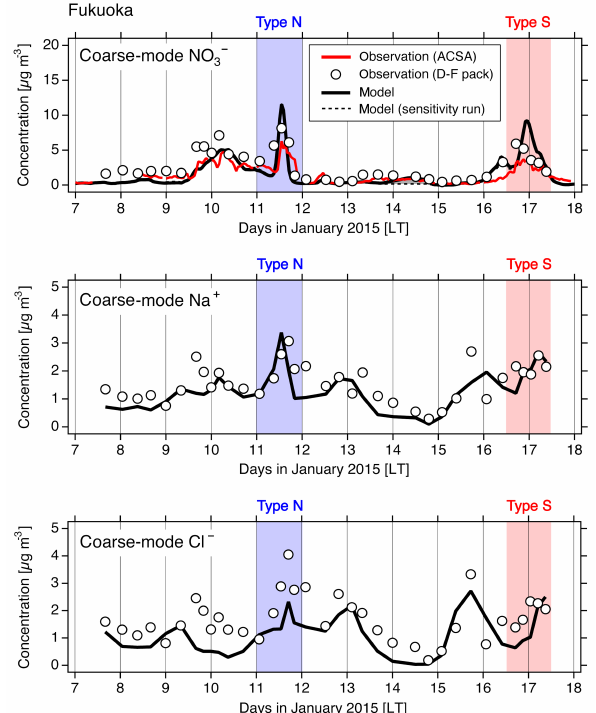
Figure 7. The temporal variation in coarse-mode NO − , Na + , and 3 Cl − at Fukuoka from 7–17 January 2015. The blue and red shading shows the type N and S patterns focused on in this study. The red lines indicate coarse-mode NO − observations by the ACSA, and 3 the open circles indicate D–F pack observations. The black lines indicate the base case simulation, and the dotted black lines indi- cate the sensitivity simulation in which the anthropogenic emissions from Japan were switched off; the differences between these results, shown in gray, represent local contributions.